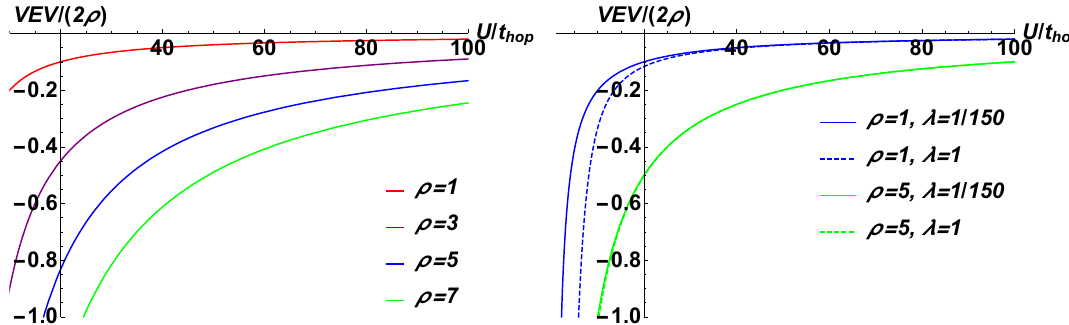
Figure 3 . The normalized VEV of the bi-fundamental is plotted as the function of U=t hop for (cid:12)xed M 2 = 0, w = 0, (cid:21) = 1 = (cid:3) 2 , (cid:3) (1 ; 1) = 3 = (2(cid:3)), and other (cid:3) ( p;r ) = 0, where the parameter (cid:3) (cid:0) is speci(cid:12)ed by eq. (3.10). The normalized VEV shows the universal t hop =U behavior at large U